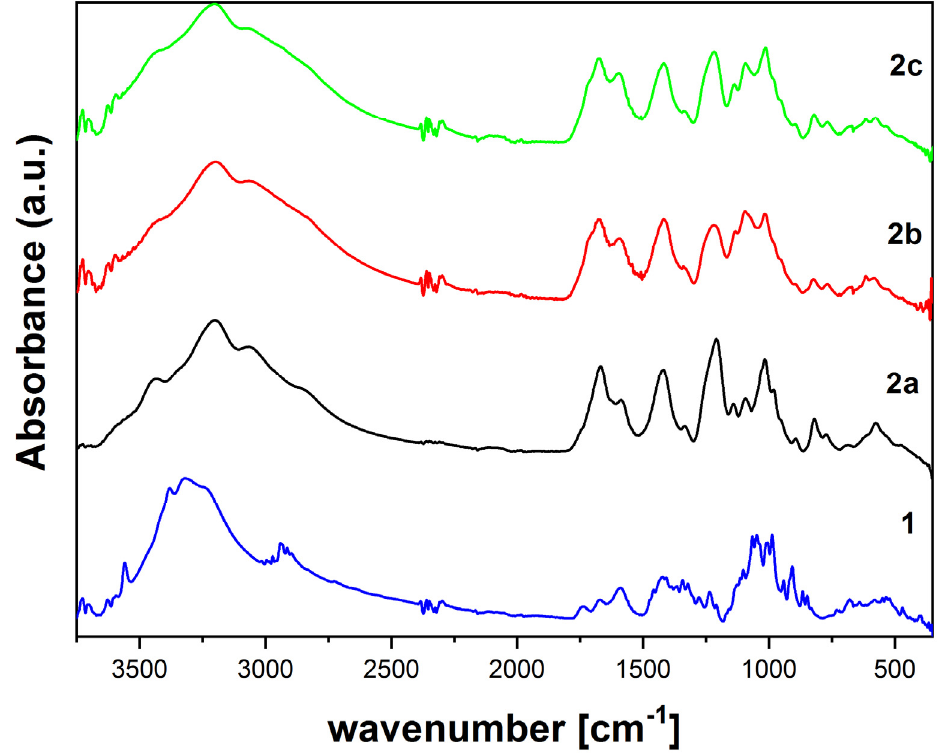
Figure 2. Normalized FTIR spectra of pectin 1 and sulfated pectins 2.